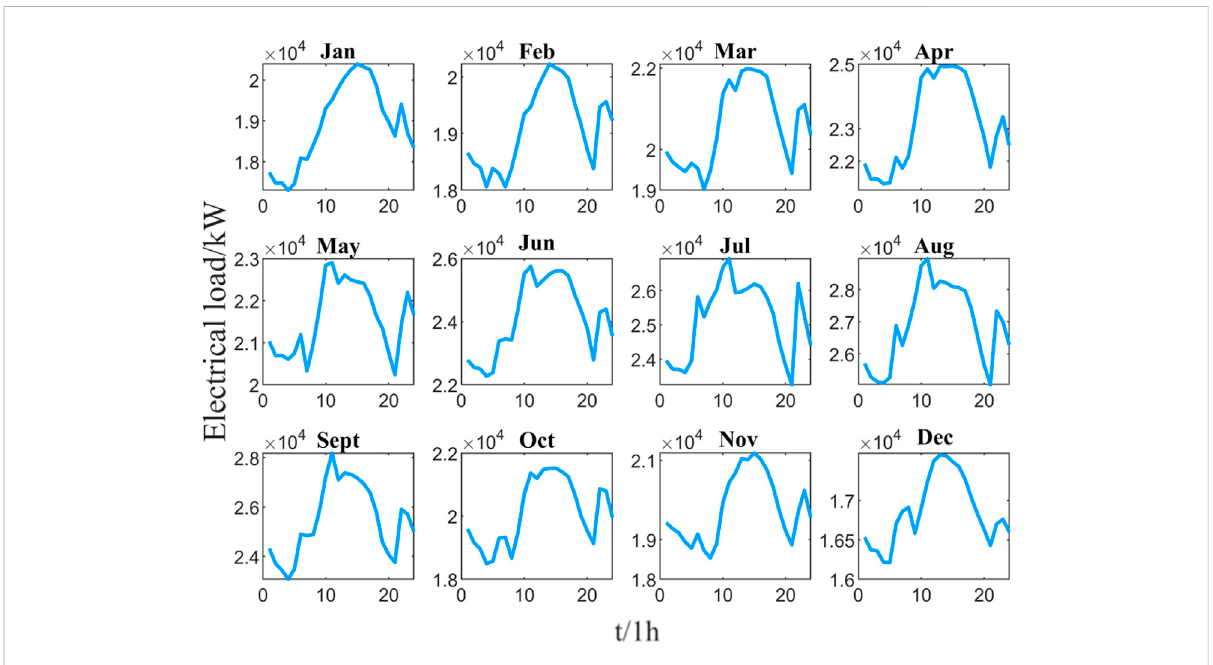
FIGURE 1 Monthly average electric daily load distribution chart.